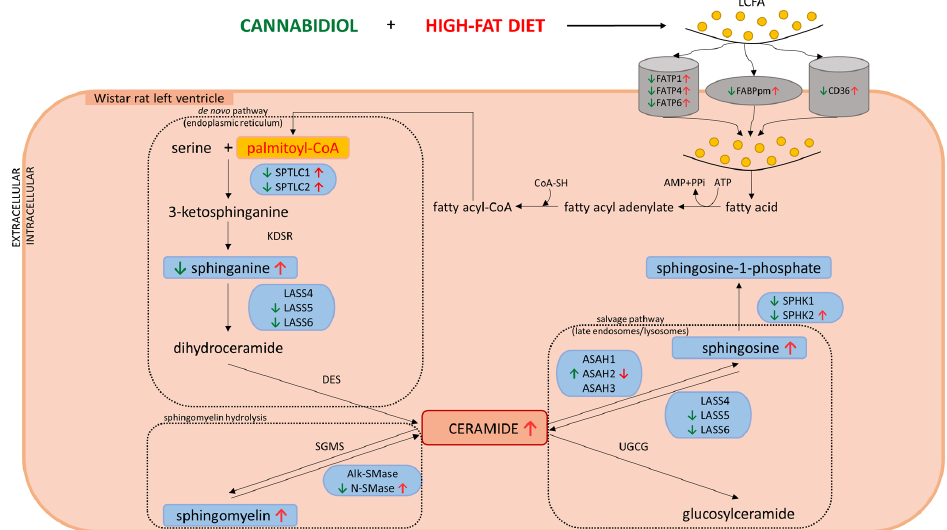
Scheme 1. Impact of high-fat diet (HFD) and 2-week cannabidiol (CBD) administration on the sphingolipid metabolic pathway in rat’s cardiomyocytes. ↑ , an increase; ↓ , a decrease; red arrows represent high-fat feeding for 7 weeks; green arrows represent the effects of 2-week CBD treatment (the last two weeks of high-fat diet regime); long chain fatty acid (LCFA), cluster of